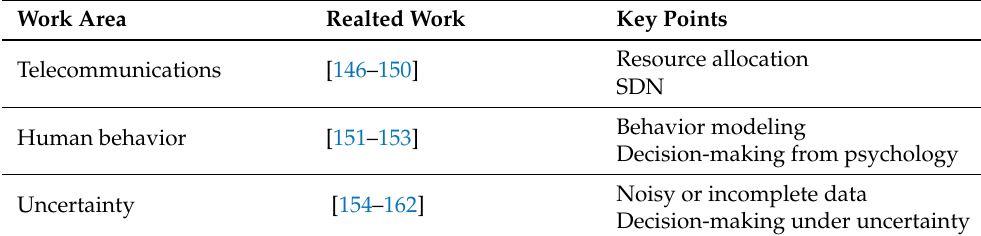
Table 7. Studies supported by deep